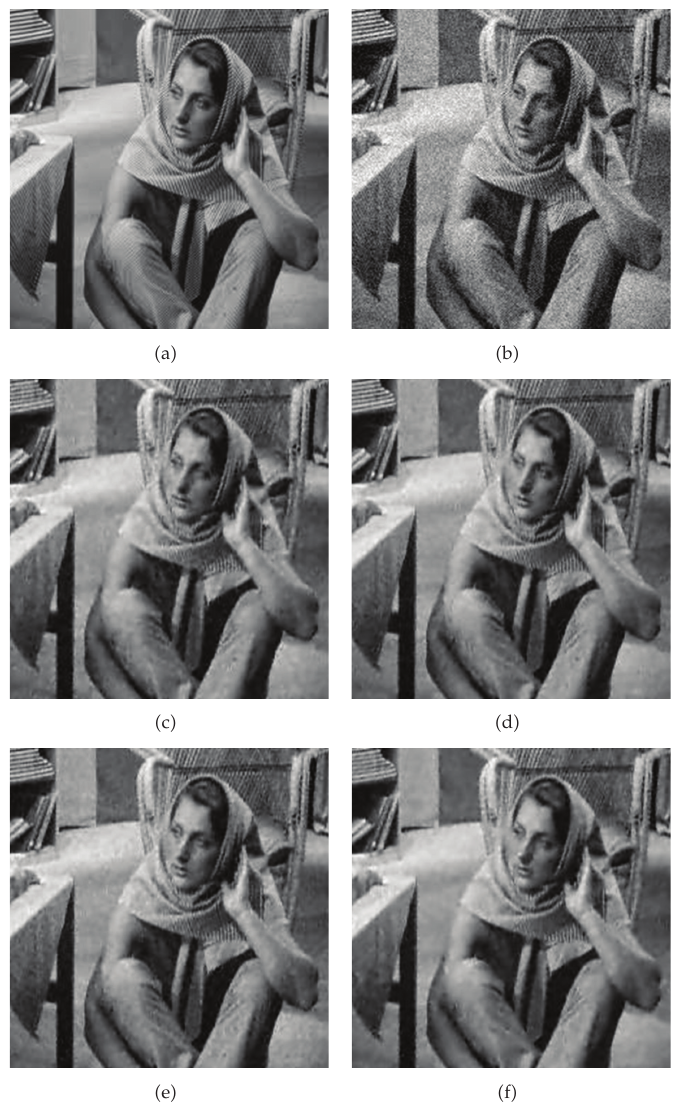
Figure 1: Comparison of di ff erent methods on “Barbara” image. (cid:3) a (cid:4) Original image. (cid:3) b (cid:4) Noised image. (cid:3) c (cid:4) Fourth-order TDE with λ (cid:7) 1. (cid:3) d (cid:4) Fourth-order TDE with λ (cid:7) 40. (cid:3) e (cid:4) Fourth-order TDE with λ (cid:7) 70. (cid:3) f (cid:4) Fourth-order TDE with λ (cid:7)